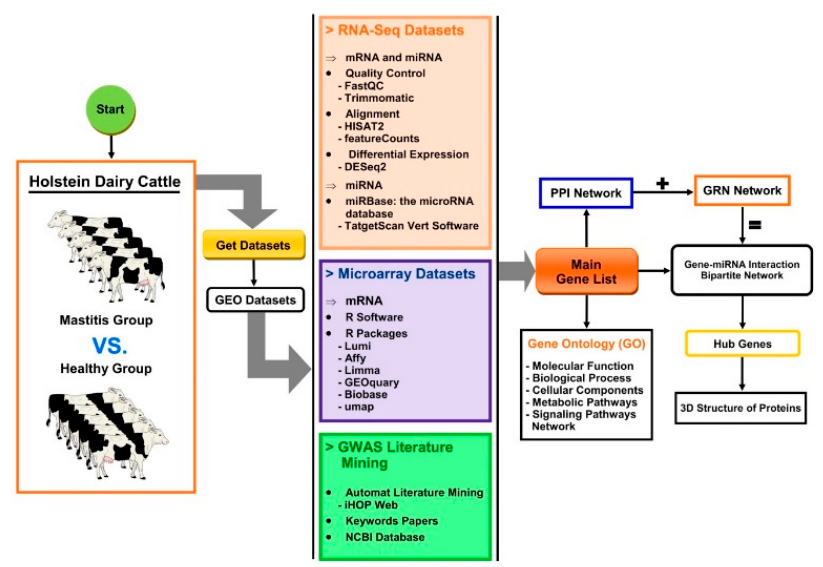
Figure 1. Schematic of the workflow used to reconstruct the metabolic pathways of mastitis in dairy cattle. The main gene list was prepared from RNA-Seq and microarray datasets, and literature mining. The protein–protein interaction network (PPI), gene regulatory network (GRN), and interactive bipartite network of gene–miRNA interactions were reconstructed using Cytoscape.